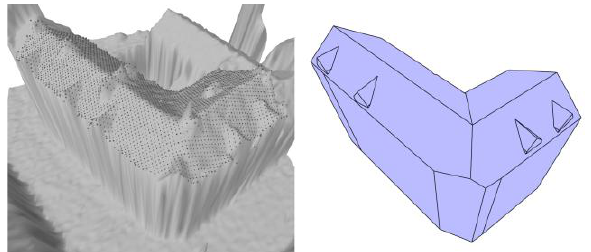
Figure 5. Digital surface model (left) and reconstructed building model (right).